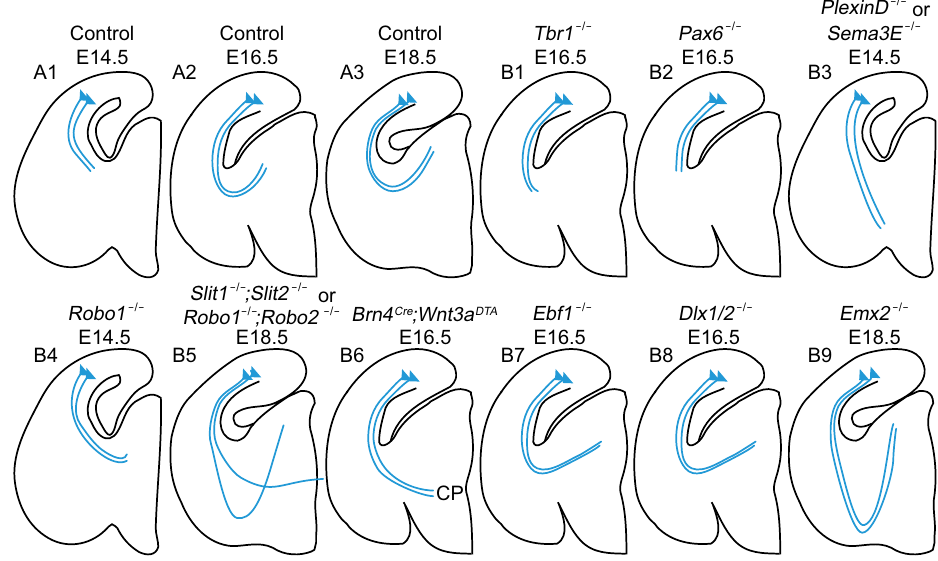
Figure 6. Schematics of defects in corticothalamic axons path fi nding. (A1 – 3) Normal developmental of corticothalamic axons path fi nding. (B1 – 9) Misled corticothalamic axons after knock out of some closely related cues. These cues are listed along the paths of corticothalamic axons. Blue lines represent CT axons. Blue triangles represent corticothalmic projecting